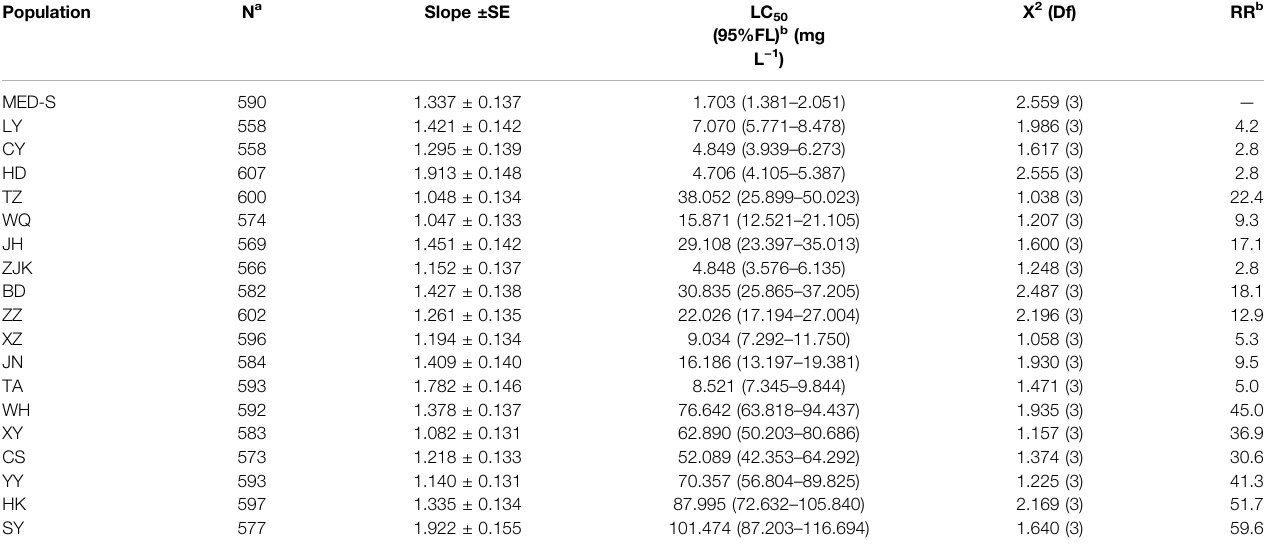
TABLE 2 | Bioassays of 18 fi eld populations and one susceptible strain of B. tabaci to cyantraniliprole. Population